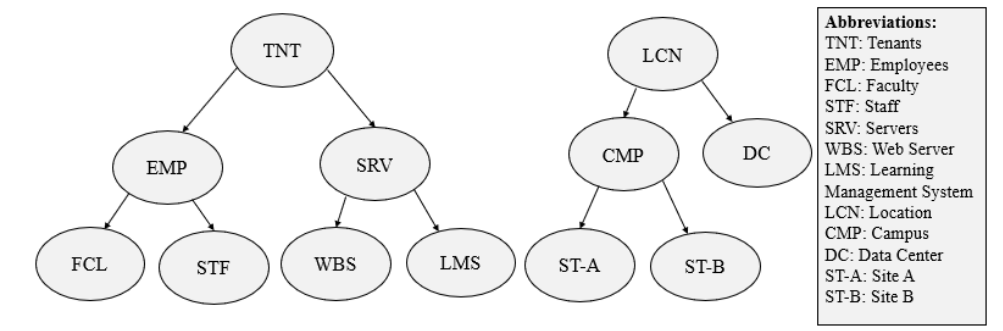
Figure 1. Input Label Namespace